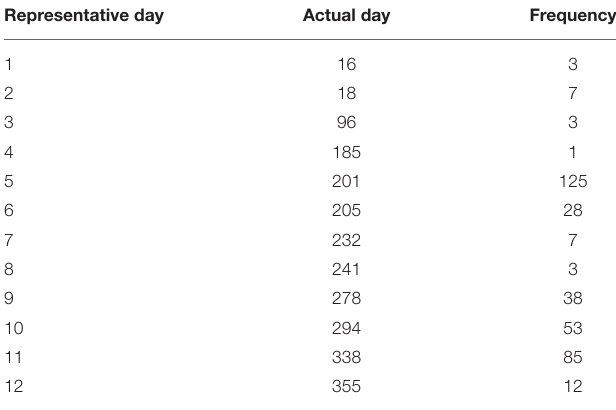
TABLE 2 | Representative days for the entire year.